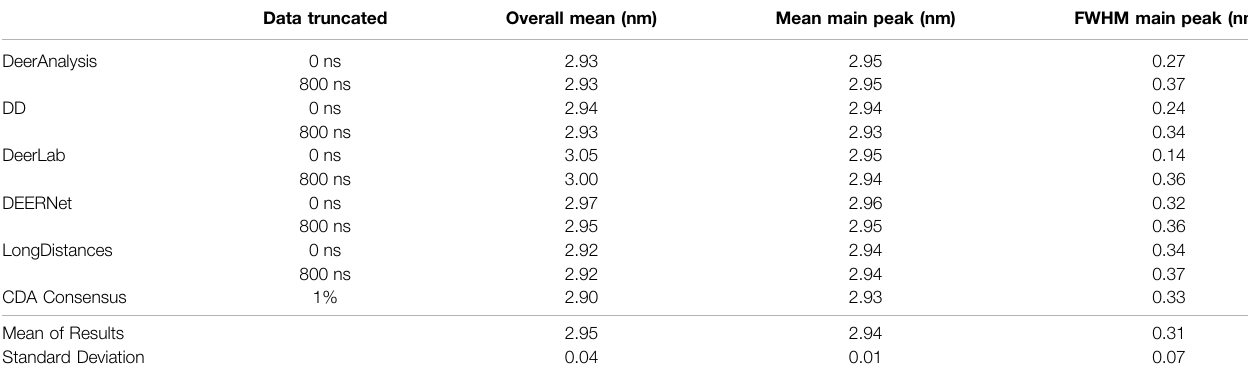
TABLE 7 | Results from each program for the DNA data set, with both 0 ns cut and 800 ns